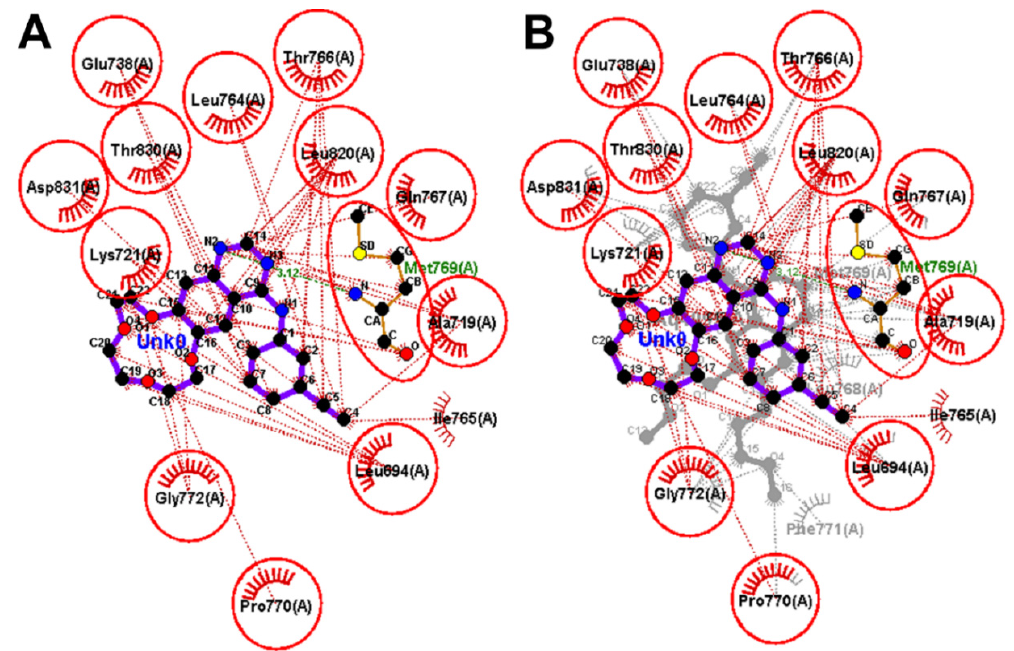
Figure 9. Binding interactions of the docked icotinib (purple sticks) into EGFR (pdb: 1M17): ( A ) icotinib; ( B ) superposed LigPlot view of icotinib (purple sticks) and the co-crystallized erlotinib (gray sticks), the red circles/ ellipses show the equivalent binding interactions, hydrogen bond interactions are displayed in olive green color dotted lines (Met769) and hydrophobic interactions are shown in brick red dotted